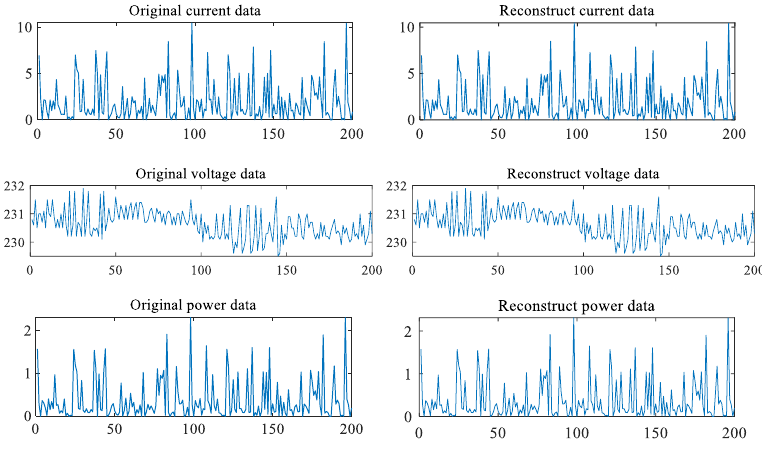
Figure 4. Original data and reconstructed data.